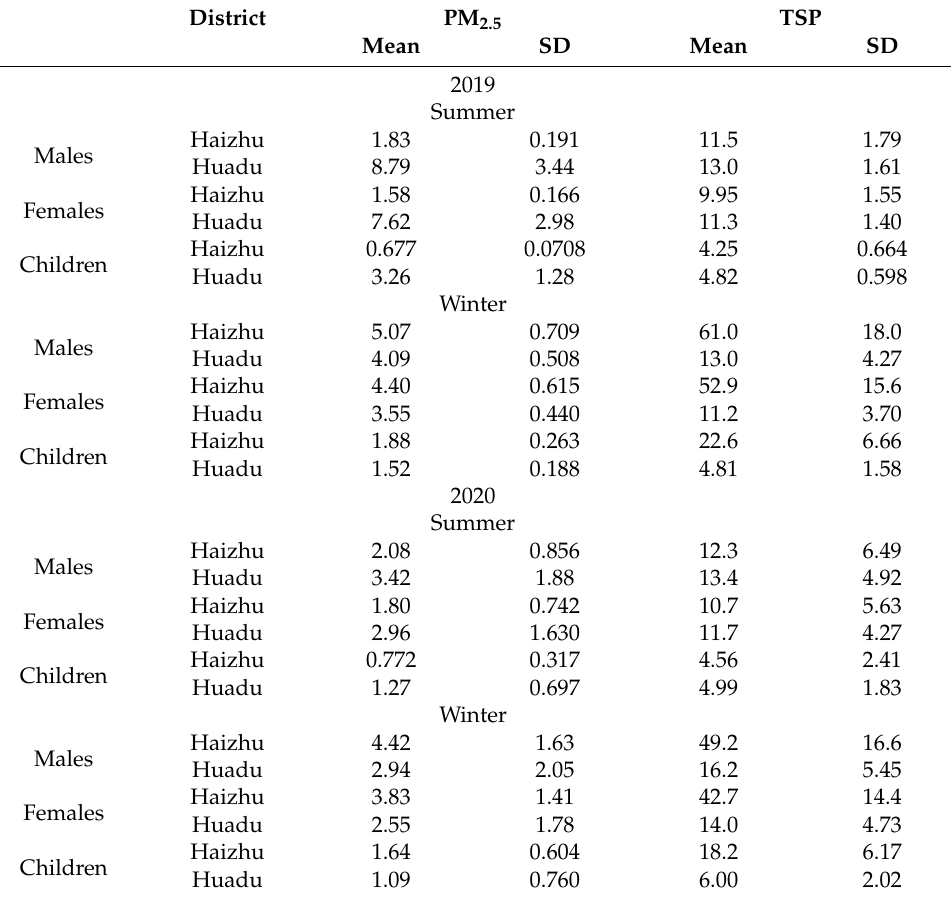
Table 4. Incremental life cancer risk (ILCR) of three nitro-PAHs (10 − 10 ) in Guangzhou from 2019 to